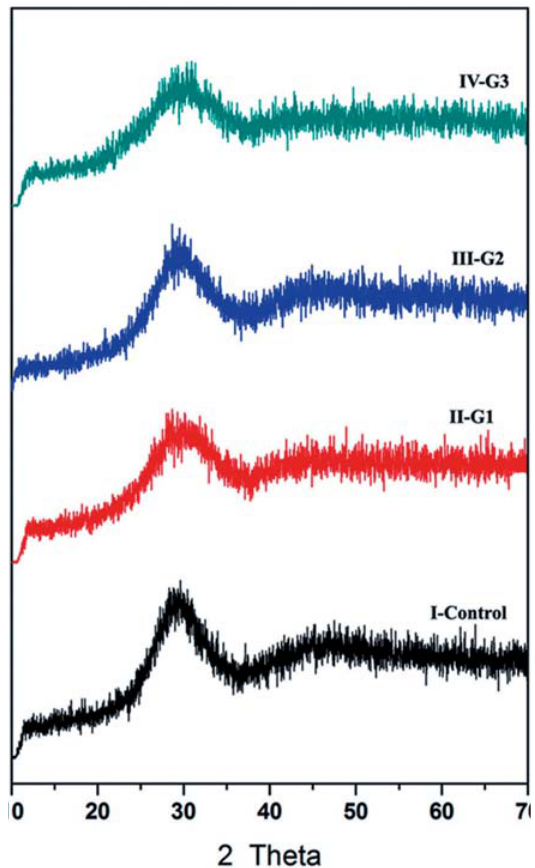
Figure 1- Powder x-ray diffraction patterns control